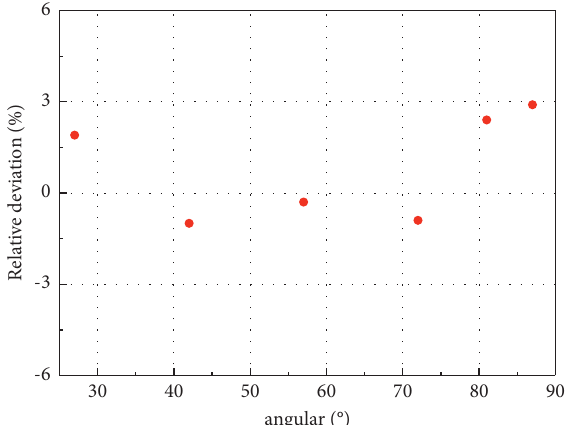
Figure 15: Relative deviations of q